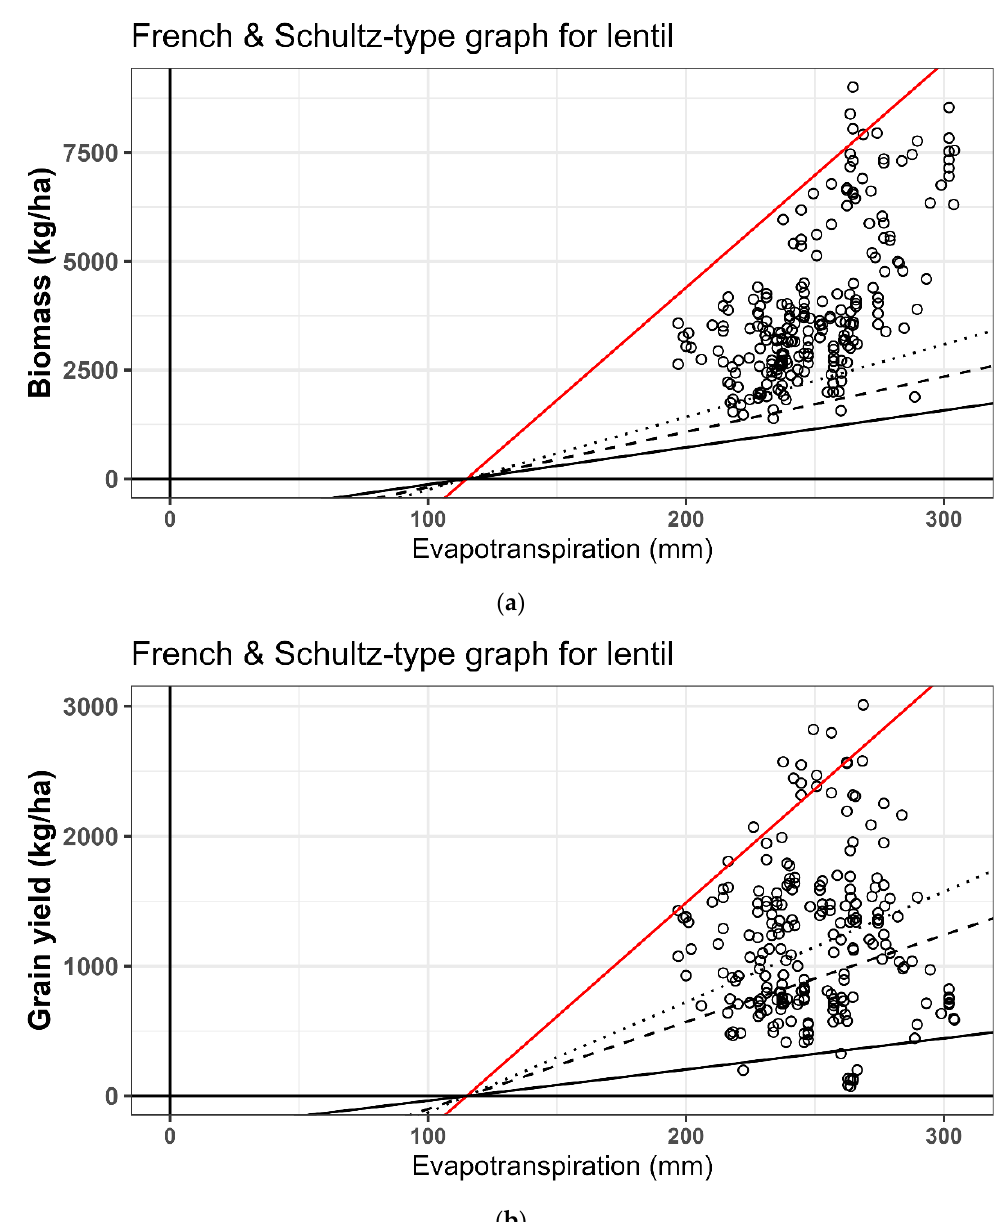
Figure 2. ( a , b ). French and Schultz [44] type graph showing the relationship between total water use during the season and biomass accumulation and grain yield. The x-intercepts (115 mm) are based on [17]. Slopes of the three drawn lines are based on values provided in [17] and [20] (top to bottom lines: maximum, mean and minimum WUE). The red lines were fitted by eye as estimated upper boundaries of this data, and to contrast them with other published values.